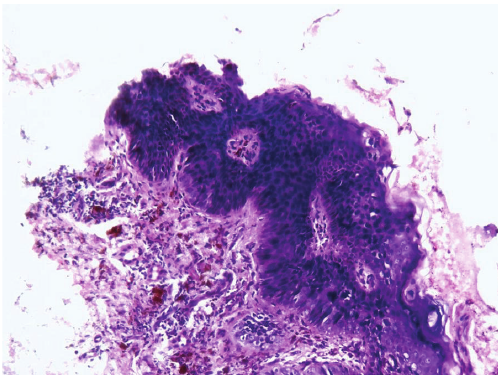
Figure 2: Epidermis shows thickening of rete ridges and paraker- atosis along with proliferation of atypical squamous epithelial cell. Basal cell layer is sharply demarcated from underlying dermis. (HE stain, magnification 10x).